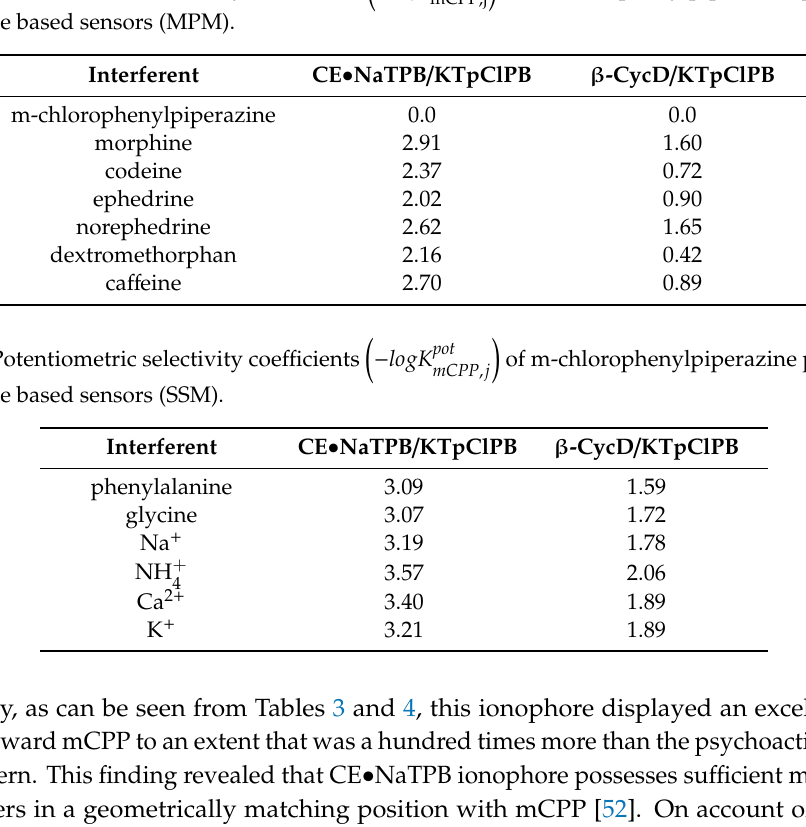
(cid:18) (cid:19) − logk MPM of m-chlorophenylpiperazine polymeric mCPP,j